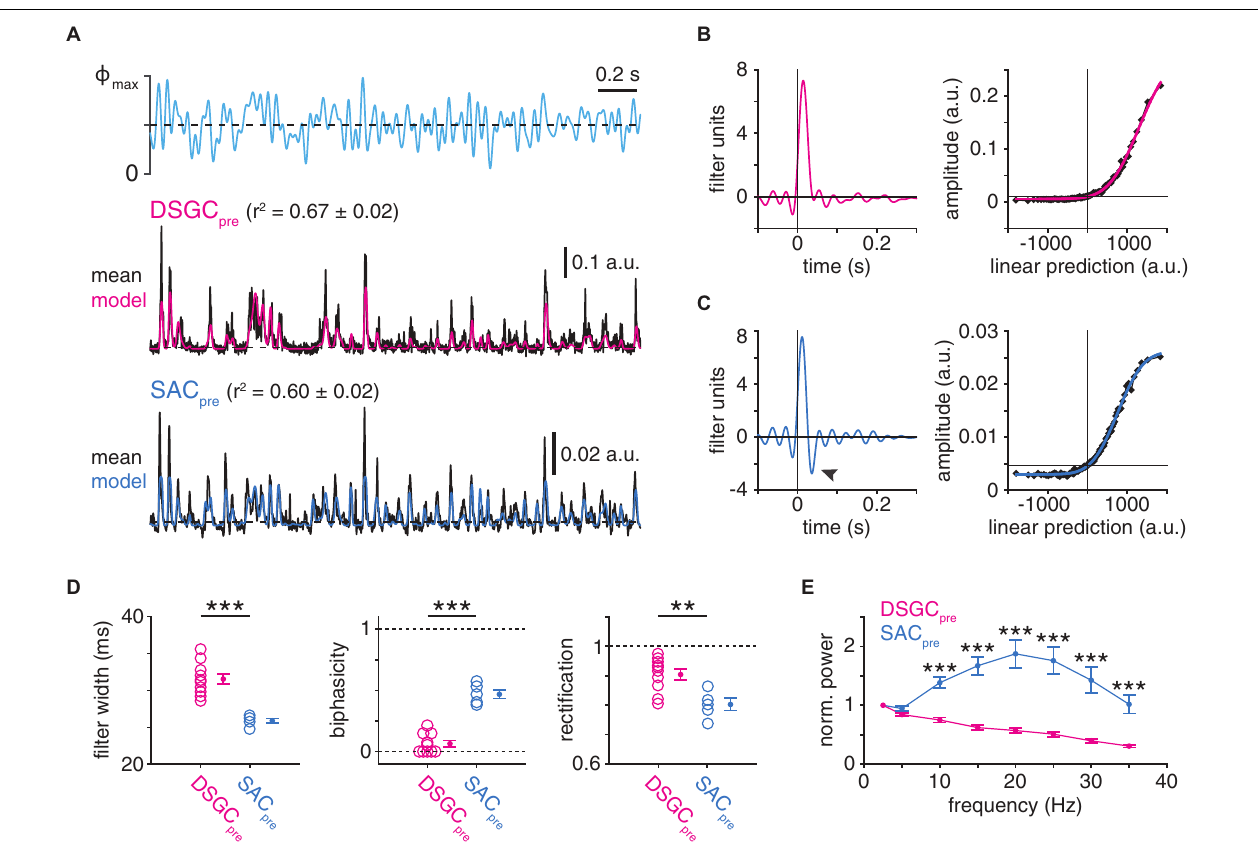
FIGURE 7 | Postsynaptic cell type-specific filtering at GABAergic SAC presynapses. (A) LN analysis of deconvolved presynaptic dynamics of GABAergic SAC synapses (see Figure 5A ). Top , optogenetic stimulus. Maximum light intensity ( (cid:56) max ), 4.8 × 10 17 Q cm − 2 s − 1 . Middle , presynaptic dynamics isolated from IPSCs recorded in an ON-OFF DSGC (DSGC pre ). Black trace shows averaged response to 10 stimulus repeats. LN model output for the same sequence is overlaid (red). Bottom , same as middle for IPSCs recorded in an ON SAC (SAC pre ; blue, LN model output). (B) Linear filter ( left ) and static nonlinearity ( right ) obtained from SAC → ON-OFF DSGC presynaptic dynamics shown in (A) . (C) Same as B for SAC → SAC presynaptic dynamics shown in (A) . Black arrowhead indicates negative lobe of linear filter. (D) Measurements of LN model components for presynaptic dynamics from IPSCs recorded in ON-OFF DSGCs ( n = 10) or ON SACs ( n = 5): filter width ( left ), filter biphasicity index ( middle ), and rectification of nonlinearity ( right ). (E) Frequency analysis of isolated presynaptic dynamics estimated from IPSC recordings of ON-OFF DSGCs and ON SACs. Power spectra are normalized to the power at 2.5 Hz and reflect the entire 100-s recording. ** p < 0.01; *** p <